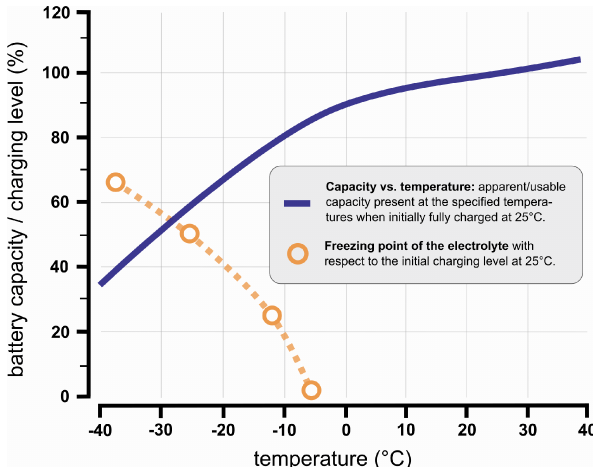
Figure 5. AGM battery performance under cold conditions. The dark blue line represents the effective usable battery capacity at the indicated temperature based on a fully (100%) charged battery at 25 ◦ C. The curve applies to an approximate electrical current flow corresponding to 5% of the total capacity of the battery (Lifeline Technical Manual, 2019). The orange circles represent the freezing point of the electrolyte. The freezing point depends on the battery charging level at 25 ◦ C. Thus, a battery charged to 50% of its total capacity at 25 ◦ C will freeze at − 25 ◦ C and at − 13 ◦ C if charged to only 25% (Lifeline Technical Manual,